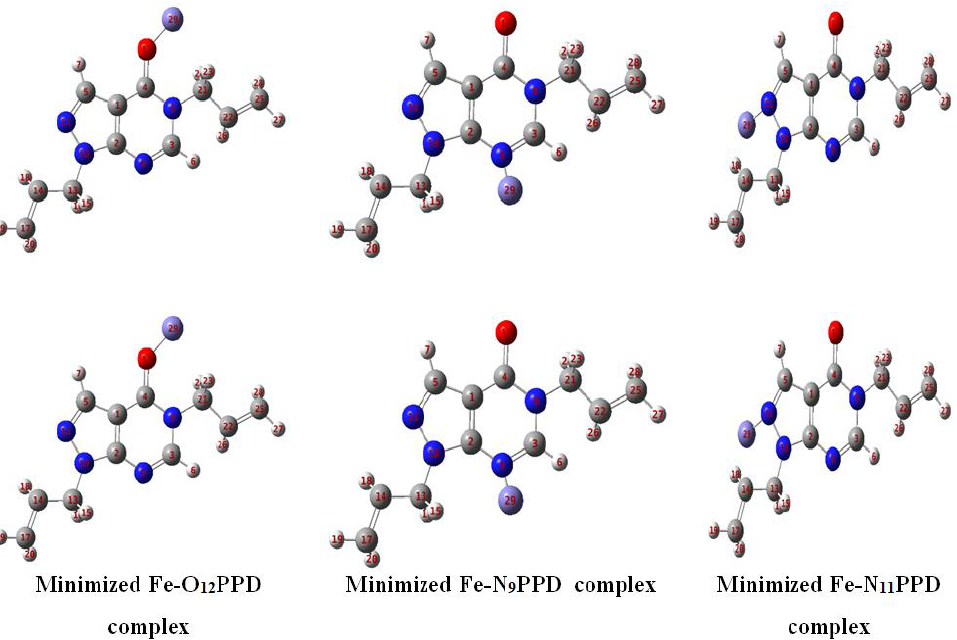
Figure 8. Energy minimized structures of Fe − O 12 PPD, Fe − N 9 PPD, and Fe − N 11 PPD complexes calculated using B 3 LYP/6-31G(d,p).